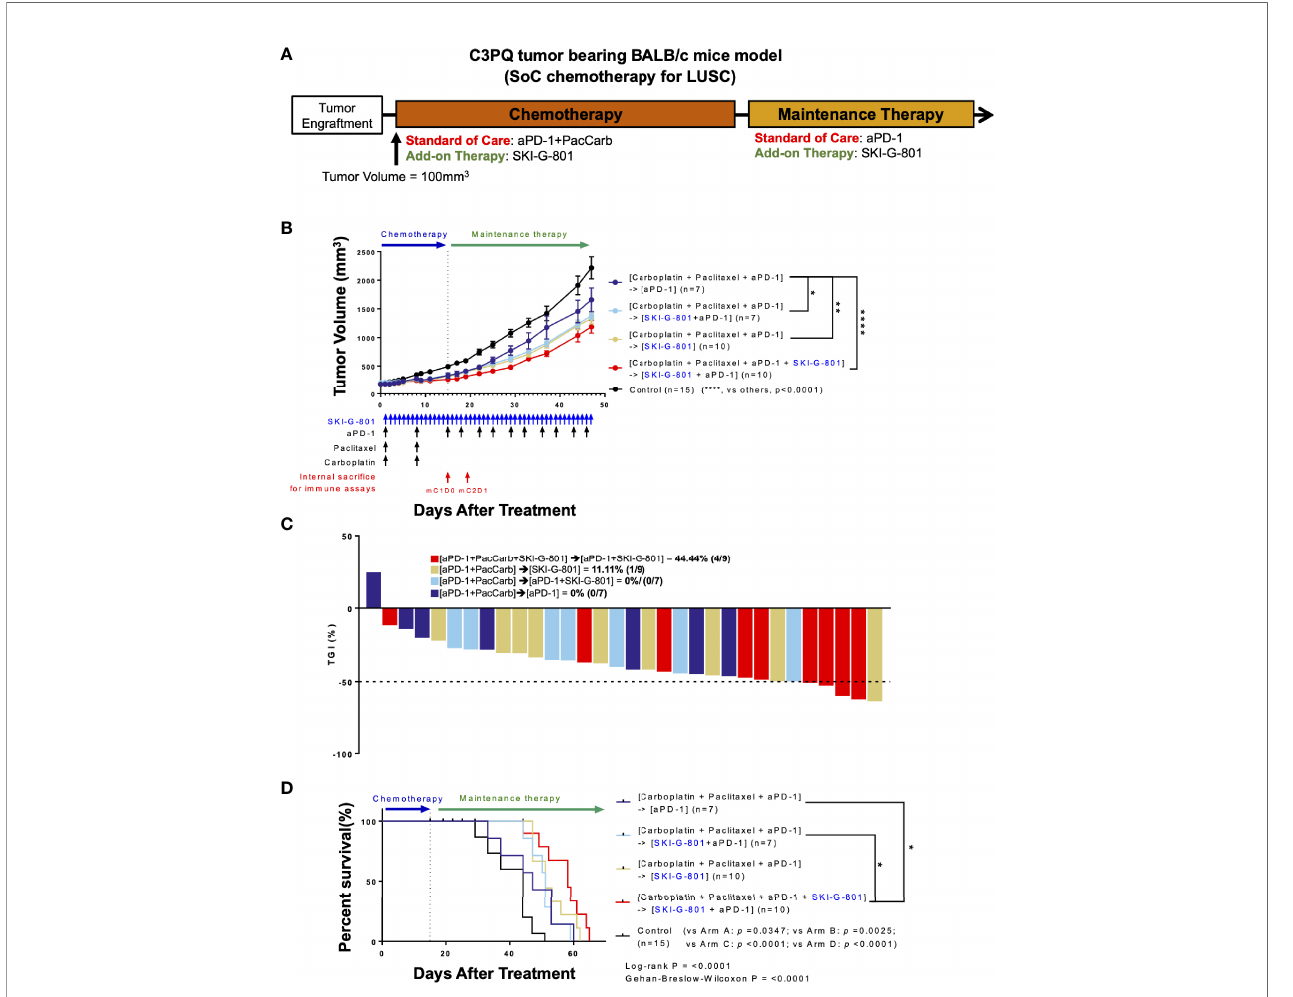
FIGURE 2 | Upfront AXL inhibitor add-on delays tumor growth, enhances tumor growth inhibition, and survival in combination with SoC chemotherapy for LUSC in C3PQ model. (A) Syngeneic C3PQ tumor cells were injected into BALB/c mice and treatment was initiated when the tumor volume reached 100mm 3 . aPD-1 + Pac + Carb were administered as standard of care for chemotherapy, and aPD-1 was administered as standard of care for maintenance therapy. (B) AXL inhibition by SKI-G-801 with standard of care signi fi cantly delayed the growth of C3PQ xenografts in BALB/c mice. Red arrows indicate sampling points during the treatment schedule (SKI-G-801 30 mg/kg, QD; Pac 20 mg/kg, QW; Carb 50 mg/kg, QW; aPD-1 10 mg/kg, BIW). Mean tumor volumes of each group and SEM images are shown. (C) Tumor growth inhibition was enhanced by upfront addition of SKI-G-801, with all of the mice in the [aPD-1+PacCarb+SKI-G-801] ! [aPD-1+SKI-G-801] group showing more than 50% TGI. Dashed line indicates -50% TGI. (D) Upfront AXL inhibition conferred enhanced overall survival to C3PQ tumor-bearing BALB/c mice. Statistical signi fi cance between groups was calculated using one-way ANOVA followed by Tukey ’ s multiple comparisons test (*p ≤ 0.05, **p ≤ 0.01, ****p ≤ 0.0001). LUSC, lung squamous cell carcinoma; aPD-1, anti-PD-1 antibody; Pac, paclitaxel; Carb, carboplatin; SEM, standard error of the mean; TGI, tumor growth inhibition; ANOVA, analysis of